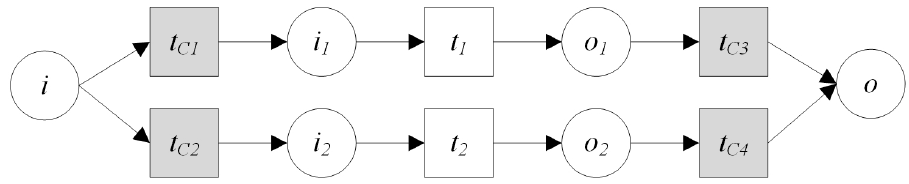
Figure 9. Alternative